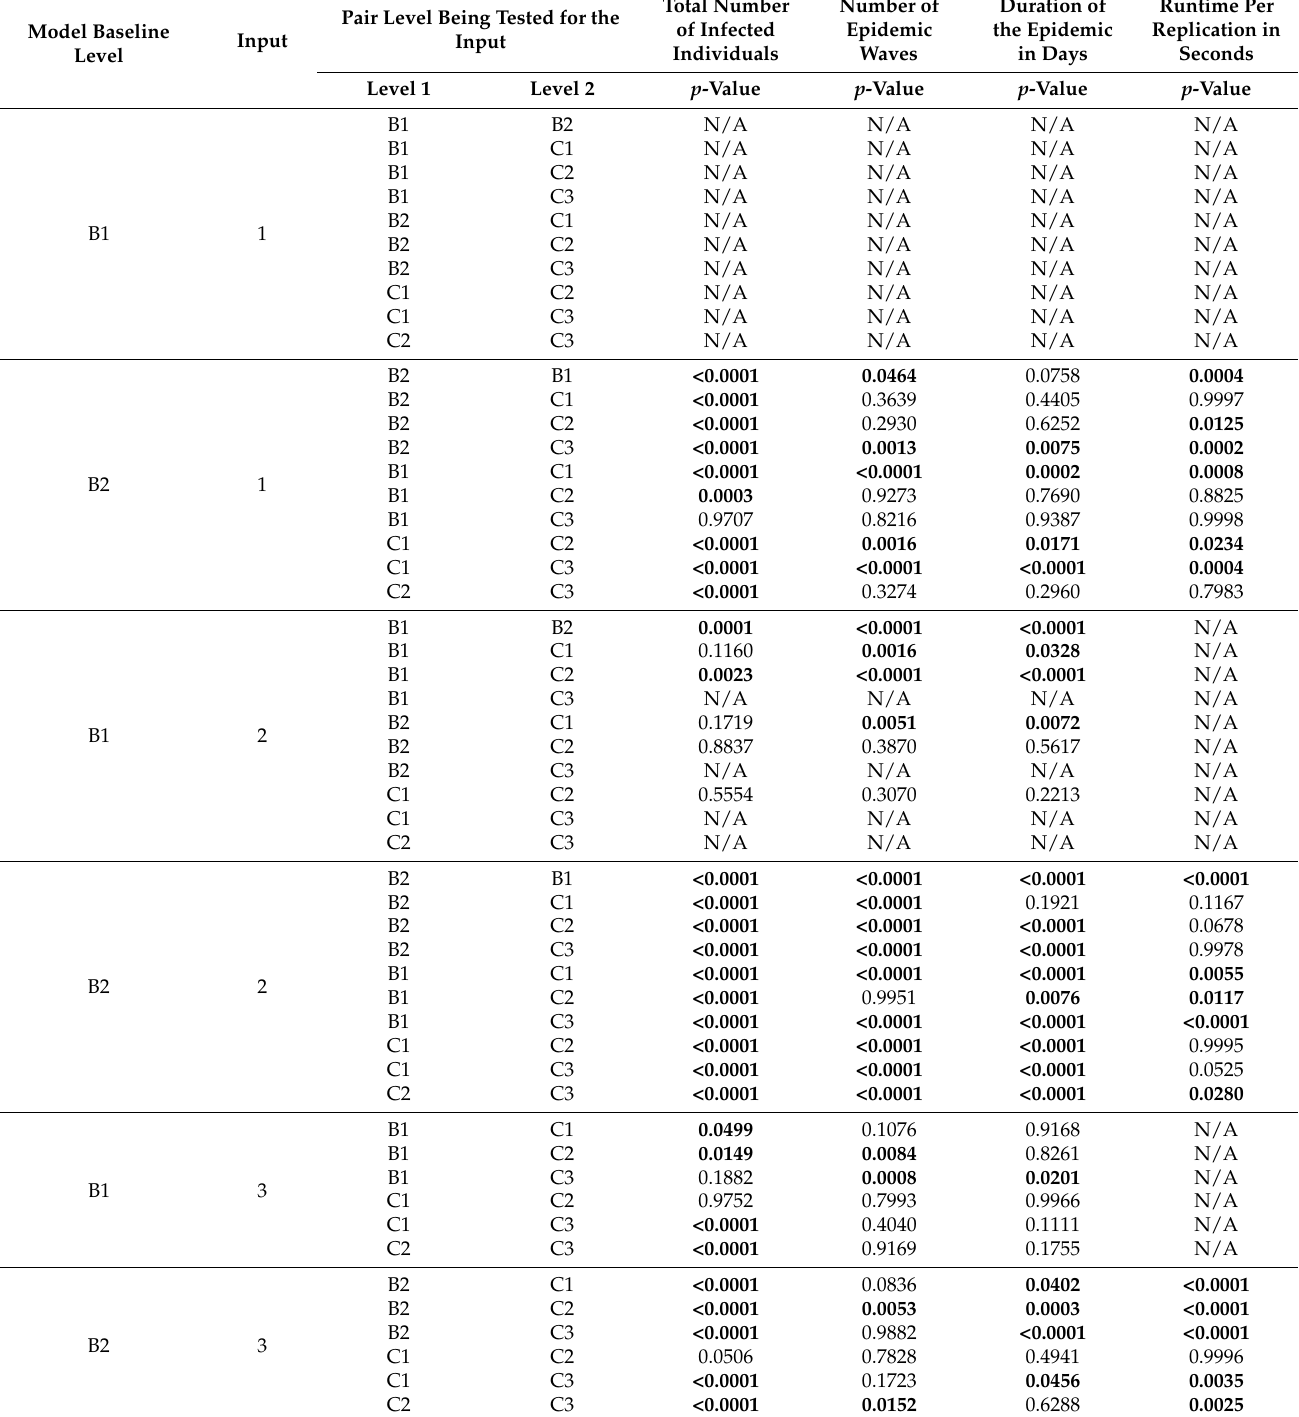
Table 10. Tukey multiple comparison results for Model B (data quality) per baseline level. Bold font denotes statistical significance at α -level of